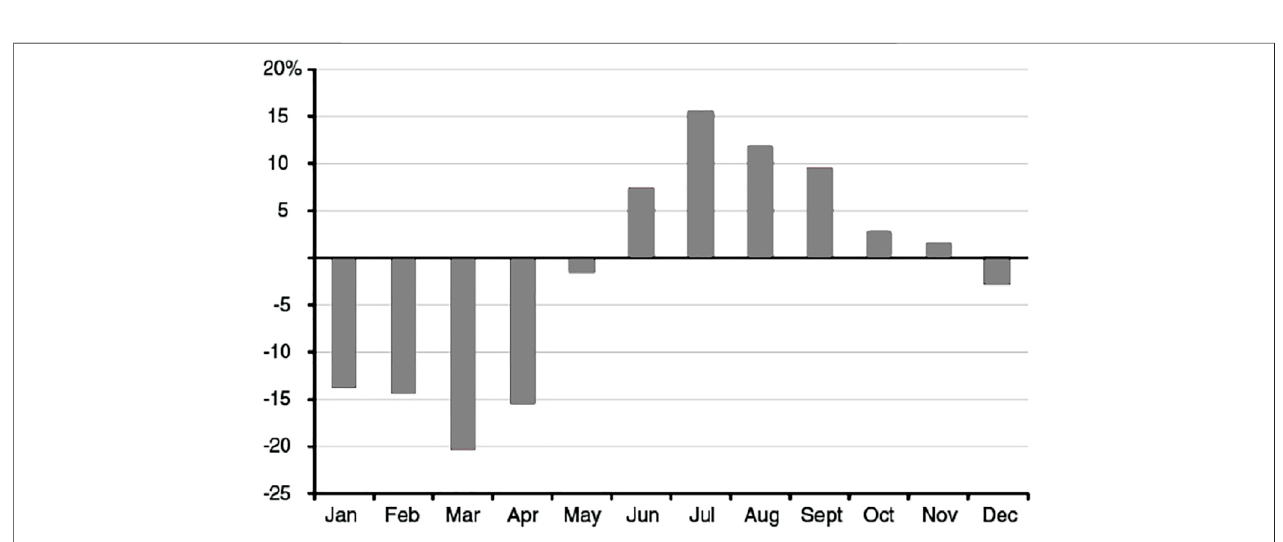
FIGURE 2 | Water use in California, percentage change from 2015 to 2016. Note: restrictions were eased by the State Water Resources Control Board in May 2016. Source: Hanak et al. (2014).